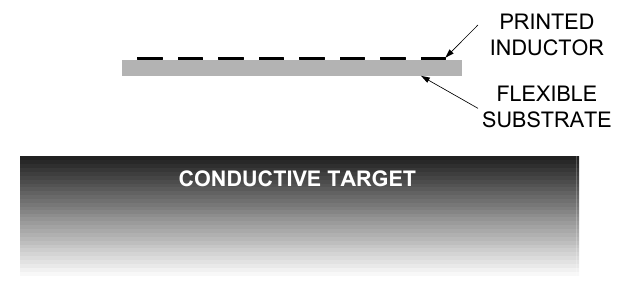
Figure 3. Cross section of the printed inductor in front of a conductive